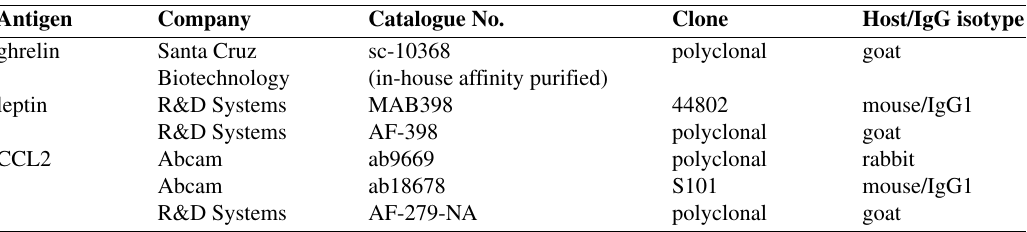
Table 1: Antibodies used as targets in affinity selection experiments.